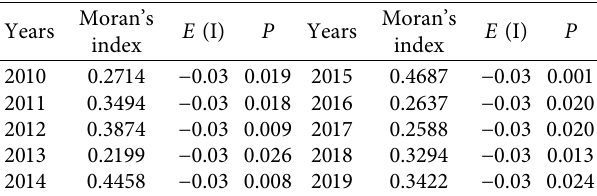
Table 2: Global autocorrelation Moran’s index of changes in China’s construction